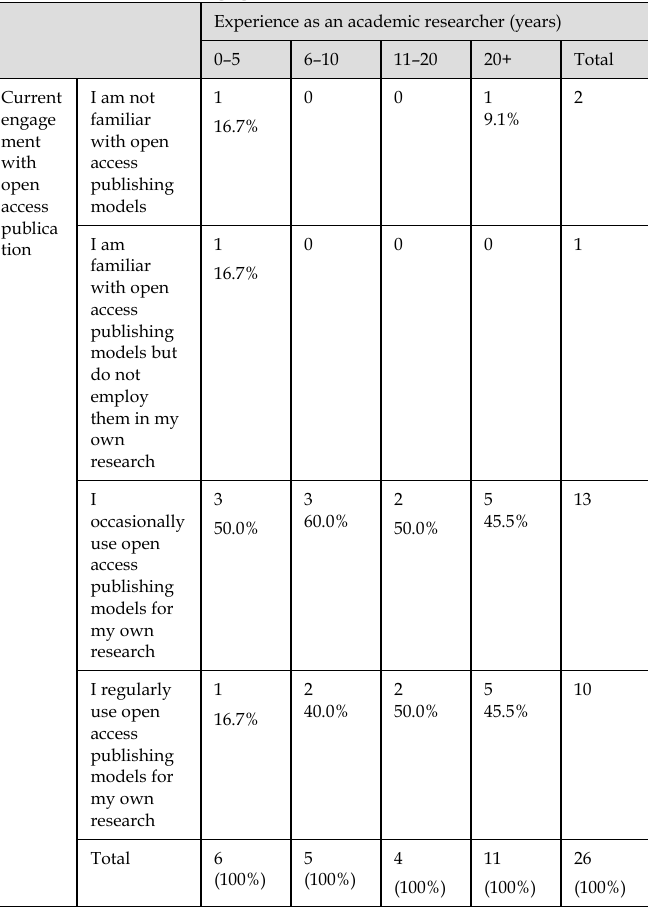
Table 5 Open access engagement by research experience.